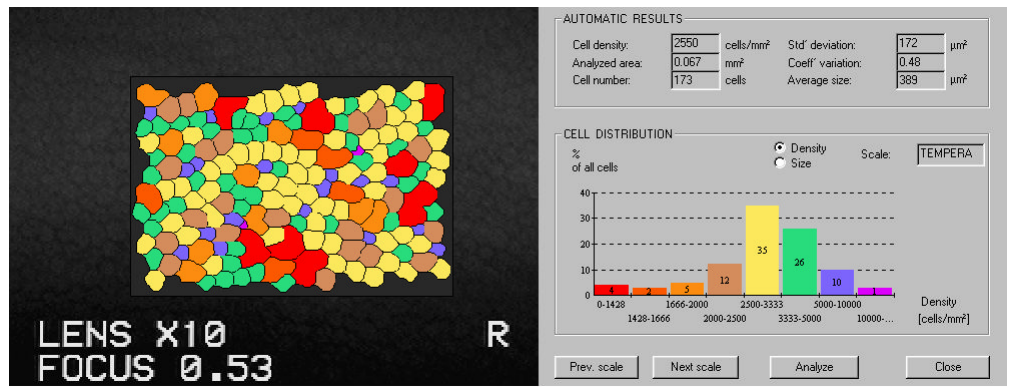
Fig. 2. Specular microscopic analysis of endothelial cell layer performed by Tomey EM 1100 equipment.